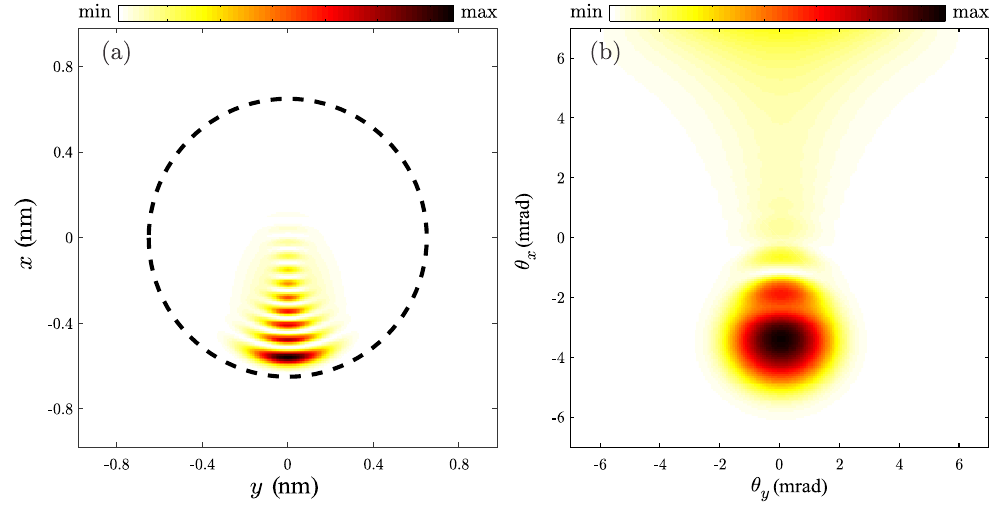
Figure 5. The probability density of the wave-packet of impact parameter b = ( 0.624,0 ) nm, in the logarithm scale, at the exit of 200-nm long chiral SWCNT (14,4) in ( a ) spatial, and ( b ) angular representation, respectively. The thick dashed line represents the SWCNT